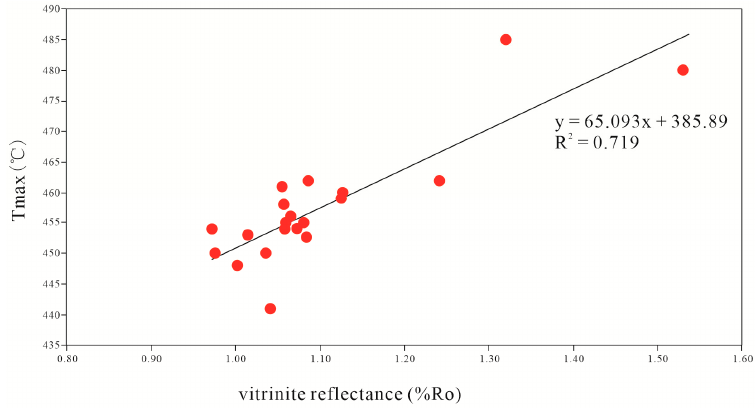
Figure 12. Plot of Ro versus pyrolysis T max .